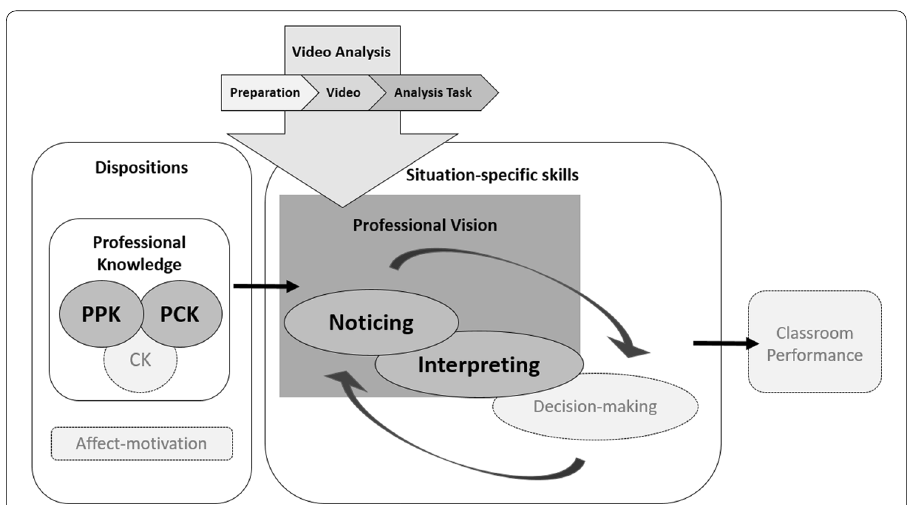
Fig. 1 Relationship Between Knowledge, Professional Vision, and Classroom Performance. This figure was adapted from Blömeke et al. (2015); from the original model, the black bolded text represents components investigated in this study while grayed-out text components are not investigated Adapted and Used with permission from Zeitschrift für Psychologie 2015; Vol. 223(1):3–13 ©2015 Hogrefe Publishing www. hogre fe. com https:// doi. org/ 10. 1027/ 2151- 2604/ a0001